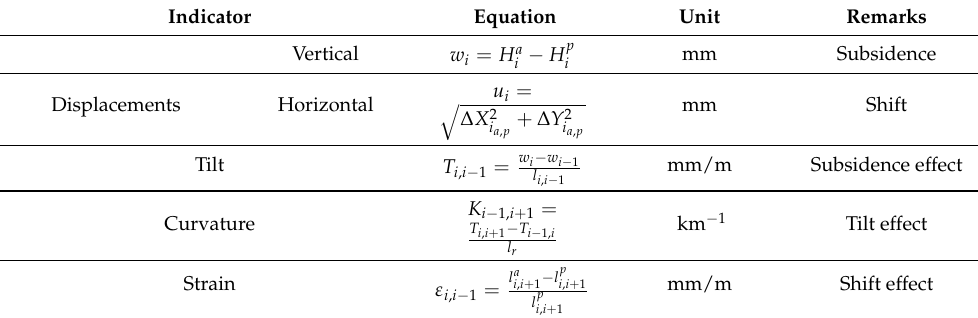
Figure 3. Deformation indicators describing ground movement over an area of underground mining operations (grey area). Left-hand side: vertical components; right-hand side: horizontal components. Table 2. Indicators characterizing subsidence trough for points with known coordinates